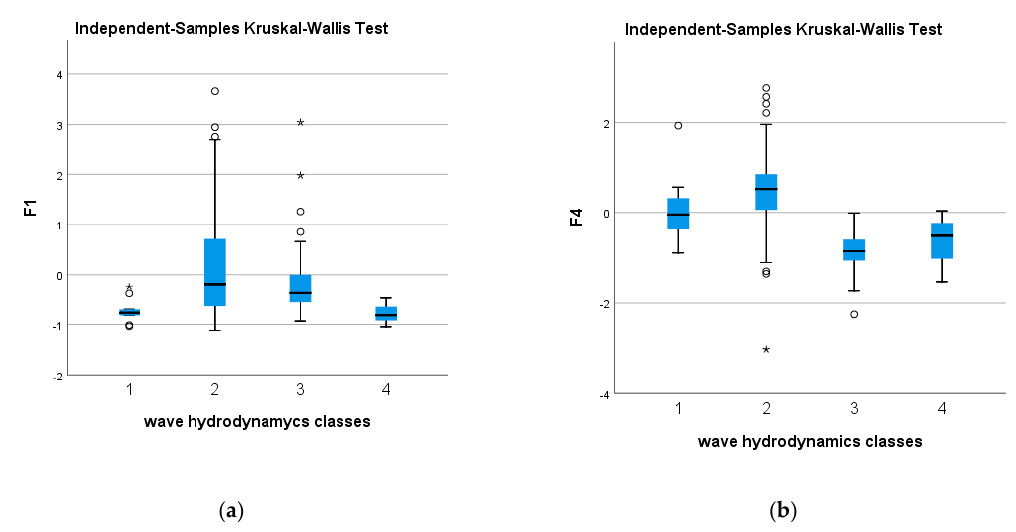
Figure 7. Box plots showing ( a ) F1 concentration values (heavy PAHs) vs. wave hydrodynamics classes; ( b ) F4 concentration values (As) vs. wave hydrodynamics classes.